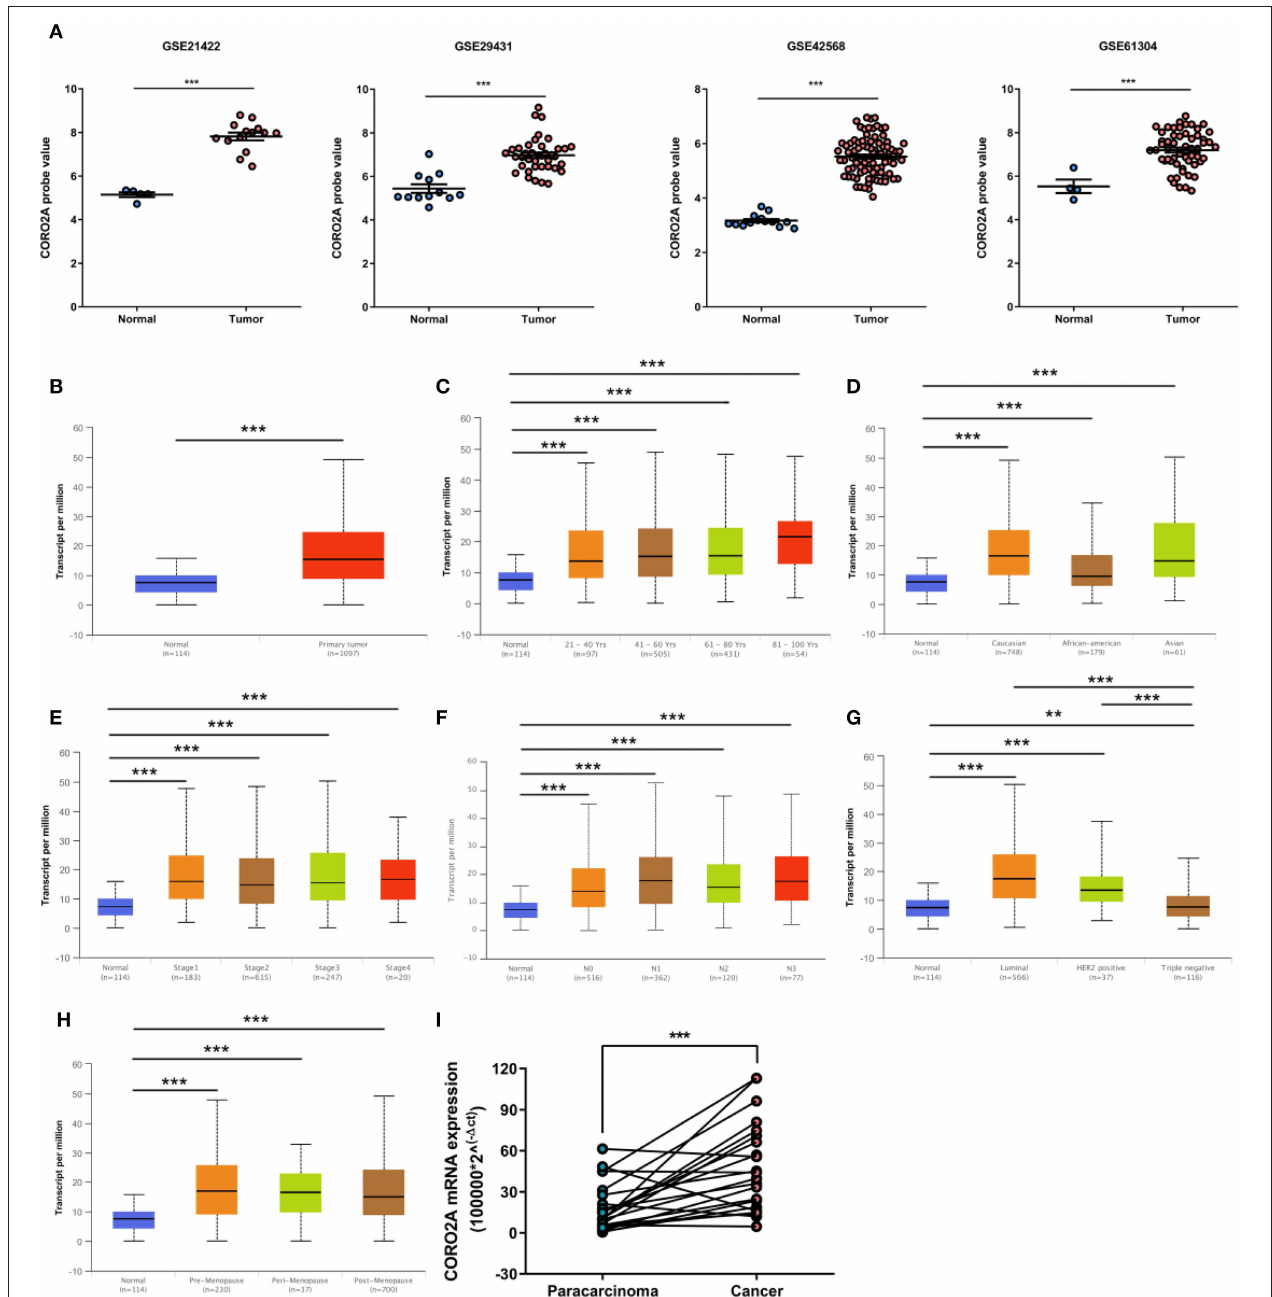
FIGURE 1 | Relative expression of CORO2A in malignant and non-malignant breast tissues. (A) Relative expression of CORO2A in malignant and non-malignant breast tissues in four GEO datasets, GSE21422, GSE29431, GSE42568, and GSE61304. Data are mean ± SEM. Student’s t -test (unpaired) was adopted to compare the statistical significance. *** P < 0.001. Panels (B–H) show CORO2A transcript in subgroups of patients with breast cancer, stratified based on age of diagnosis, gender, and other criteria (UALCAN). (B) Relative expression of CORO2A in normal and breast cancer samples. (C) Relative expression of CORO2A in normal individuals or in breast cancer patients with different age. (D) Relative expression of CORO2A in normal individuals or in breast cancer patients with differential ethnicity. (E) Relative expression of CORO2A in normal individuals or in breast cancer patients with differential tumors stages. (F) Relative expression of CORO2A in normal individuals or in breast cancer patients with differential nodal metastatic status. (G) Relative expression of CORO2A in normal individuals or in breast cancer patients with differential tumors subclasses. (H) Relative expression of CORO2A in normal individuals or breast cancer patients with differential menopause status. Data are mean ± SEM. ** P < 0.01; *** P < 0.001. (I) Comparison of CORO2A mRNA expression between breast cancer tissues and paracancerous tissues ( n = 22). β -actin was used as an internal reference gene for normalization. Data were analyzed using paired Student’s t -test.